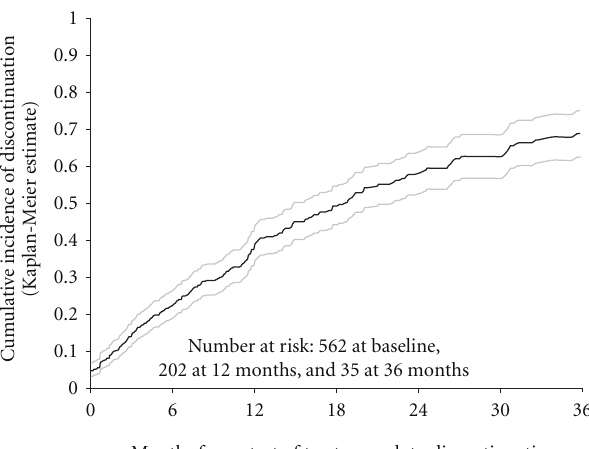
Figure 2: Cumulative rate of trastuzumab discontinuation in wom- en with metastatic breast cancer. Note: Light gray bars represent 95% confidence interval